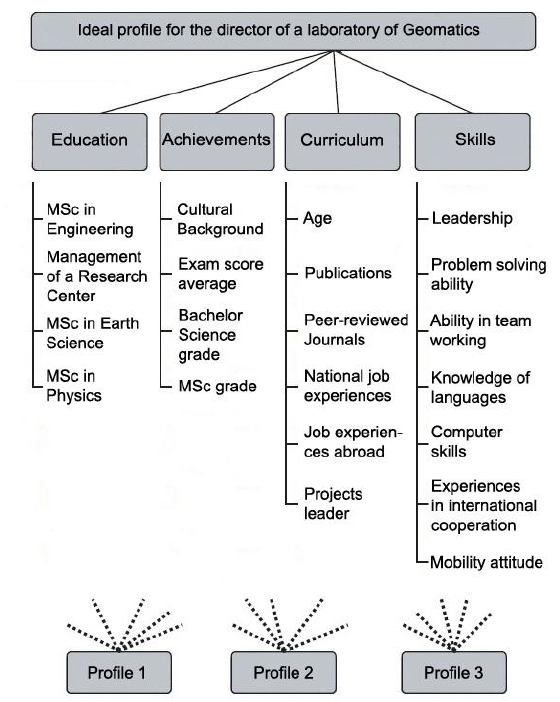
Figure 5. Case study hierarchy of dominance